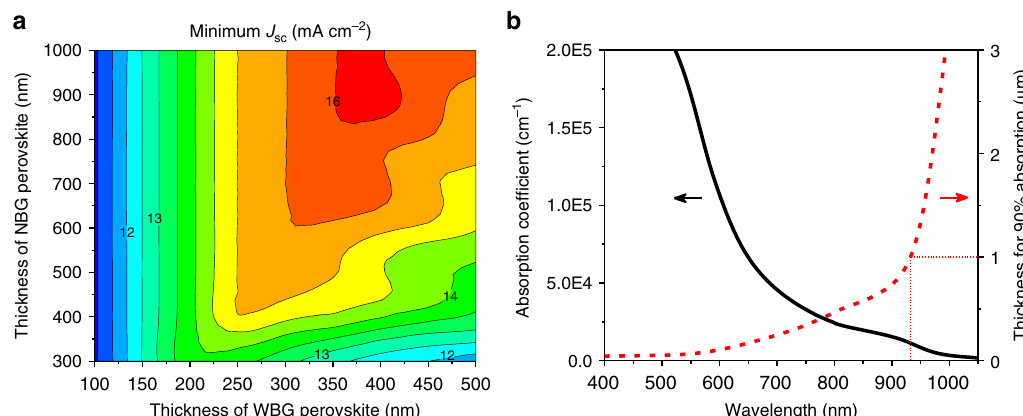
Fig. 1 Simulation of the NBG and monolithic perovskite tandem solar cells. a Simulated J SC of perovskite – perovskite tandem solar cells with assumption of 90% EQE in the whole absorption spectrum. In the simulation, the NBG FA 0.5 MA 0.45 Cs 0.05 Pb 0.5 Sn 0.5 I 3 and WBG FA 0.6 Cs 0.4 Pb(I 0.65 Br 0.35 ) 3 perovskites have bandgaps of 1.22 eV and 1.80 eV, respectively. b Absorption coef fi cient of FA 0.5 MA 0.45 Cs 0.05 Pb 0.5 Sn 0.5 I 3 with a bandgap of 1.22 eV, and corresponded thickness of the fi lms that is needed to absorb 90% of different incident light. Source data are provided as a Source Data fi le